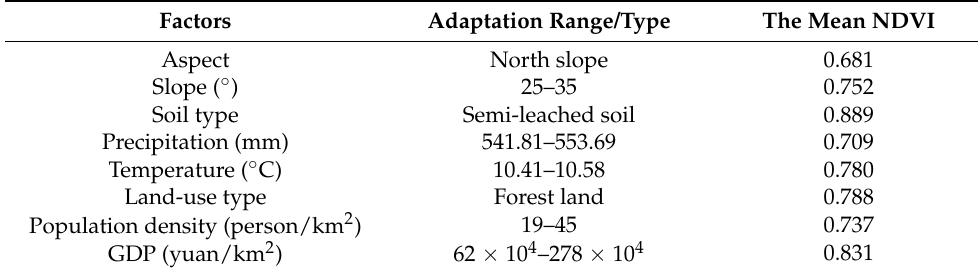
Table 11. Adaptation ranges/types suitable of factors to vegetation.